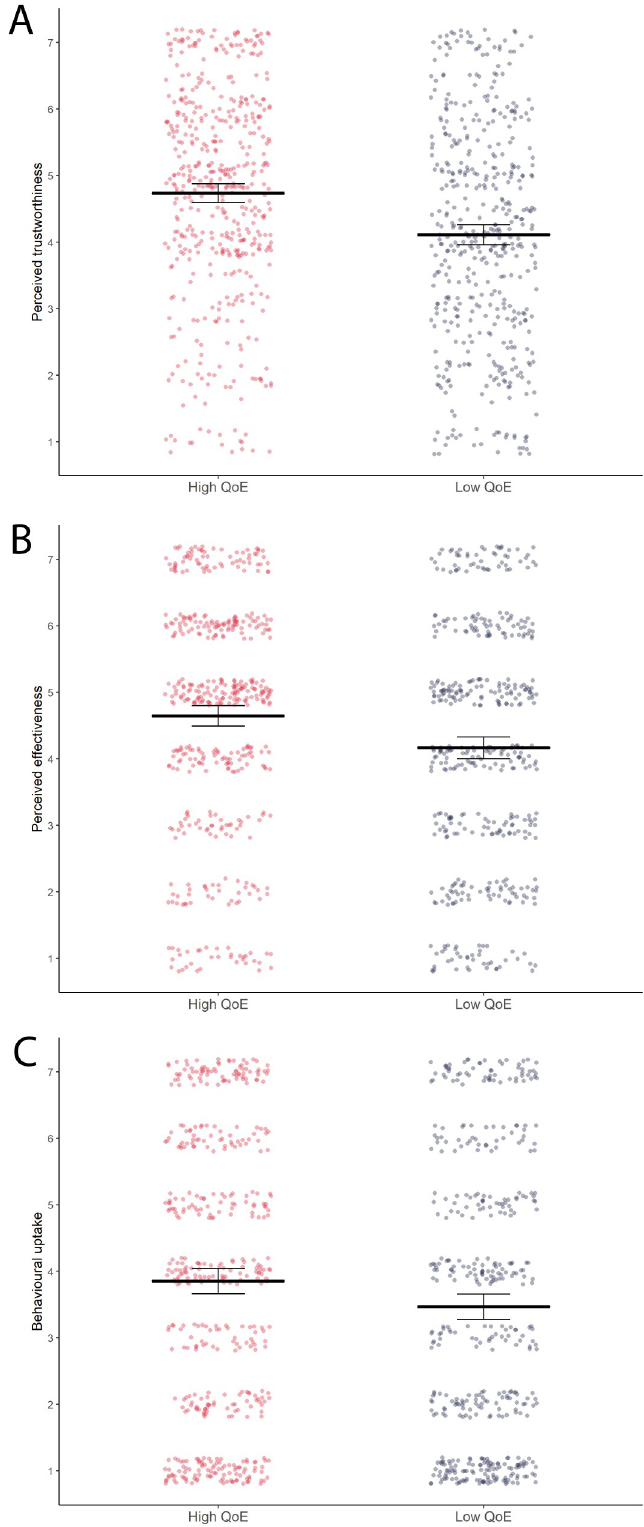
Fig 2. The effects of giving a cue as to the certainty/quality of evidence (QoE) behind an effectiveness estimate on people’s perceptions of the trustworthiness of the information (A), the perceived effectiveness of the